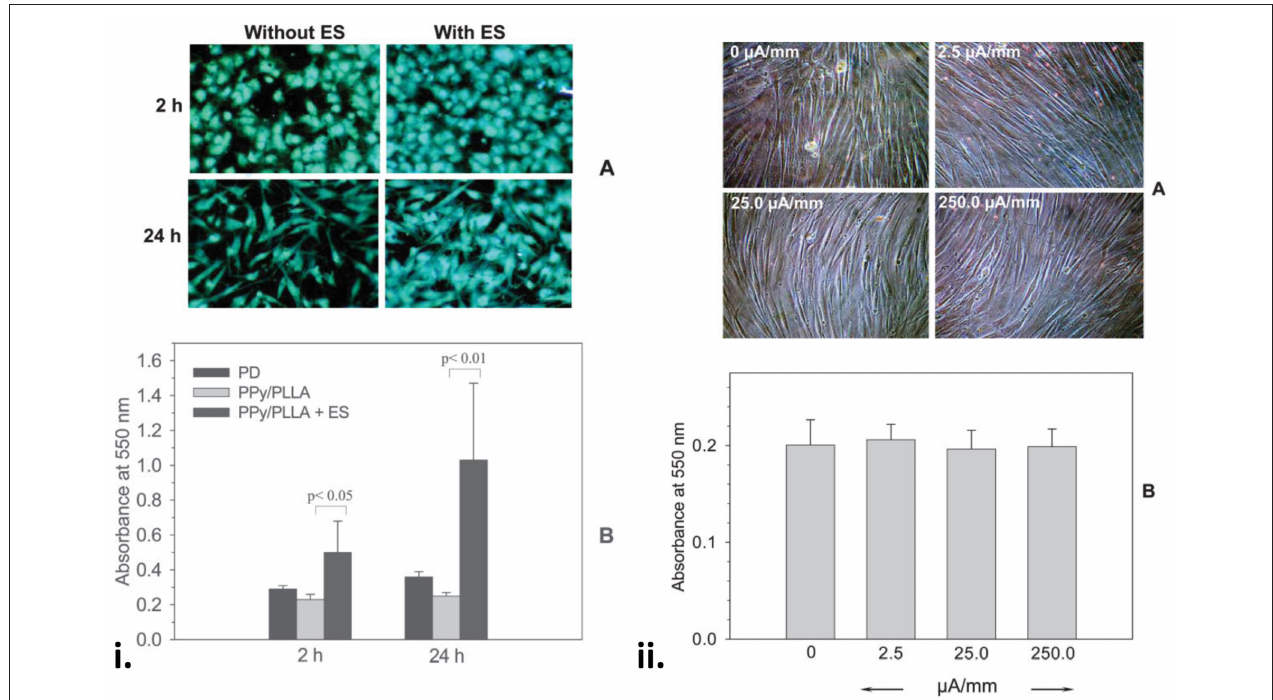
FIGURE 4 | (i) Fibroblasts on the PPy/PLLA membranes at 2 and 24h with or without ES. Note the comparable cell distribution and high cell density on the ES membranes (A) . (B) Shows a significantly higher cell viability on the membranes with ES (100 mV/mm). (ii) Fibroblasts on the gold-coated tissue culture Petri dish for 96h with or without ES at various surface current densities, showing that a wide range of DC current density had no effect on cell morphology (A) and viability (B) . Reproduced with permission from Shi et al. (103).